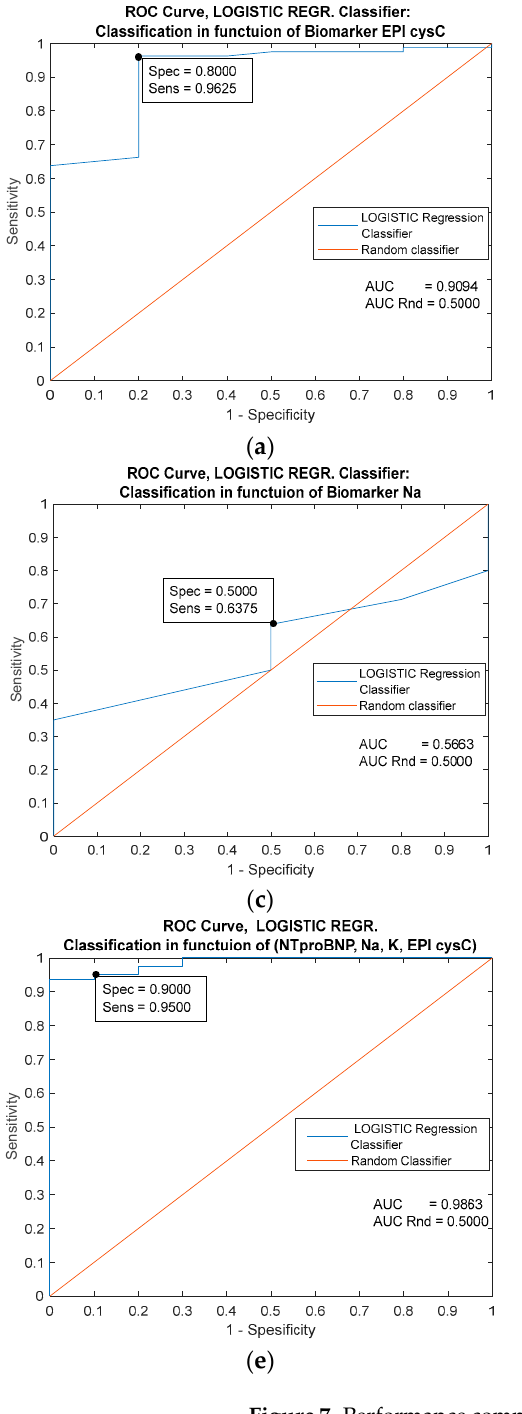
Figure 7. Performance comparison of logistic regression classifiers based on four individual predictors ( a – d ) and on the combination of all the mentioned predictors ( e ).